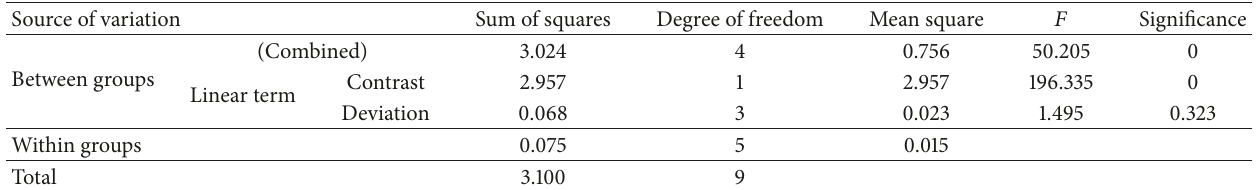
Table 5: ANOVA: single factor between the groups of different particle contents on failure temperature.